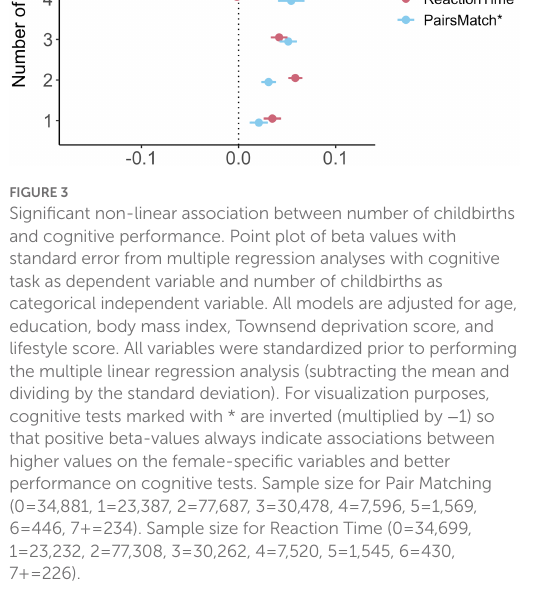
(Supplementary Table S15), except for number of live childbirths as well as number of live childbirths squared and simple processing speed (Reaction time: N Childbirths β = 0.039, p FDR = 0.022, N Childbirths (Taylor et al., 2019) β = − 0.046, p FDR = 0.017). However,